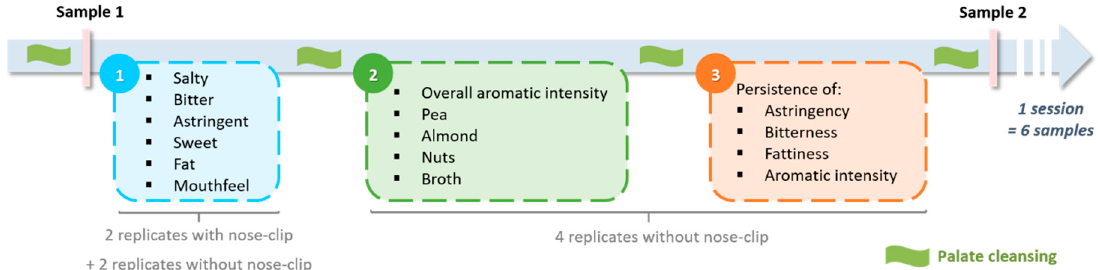
Figure 1. Schematic representation of the static block profiling method used in this study.